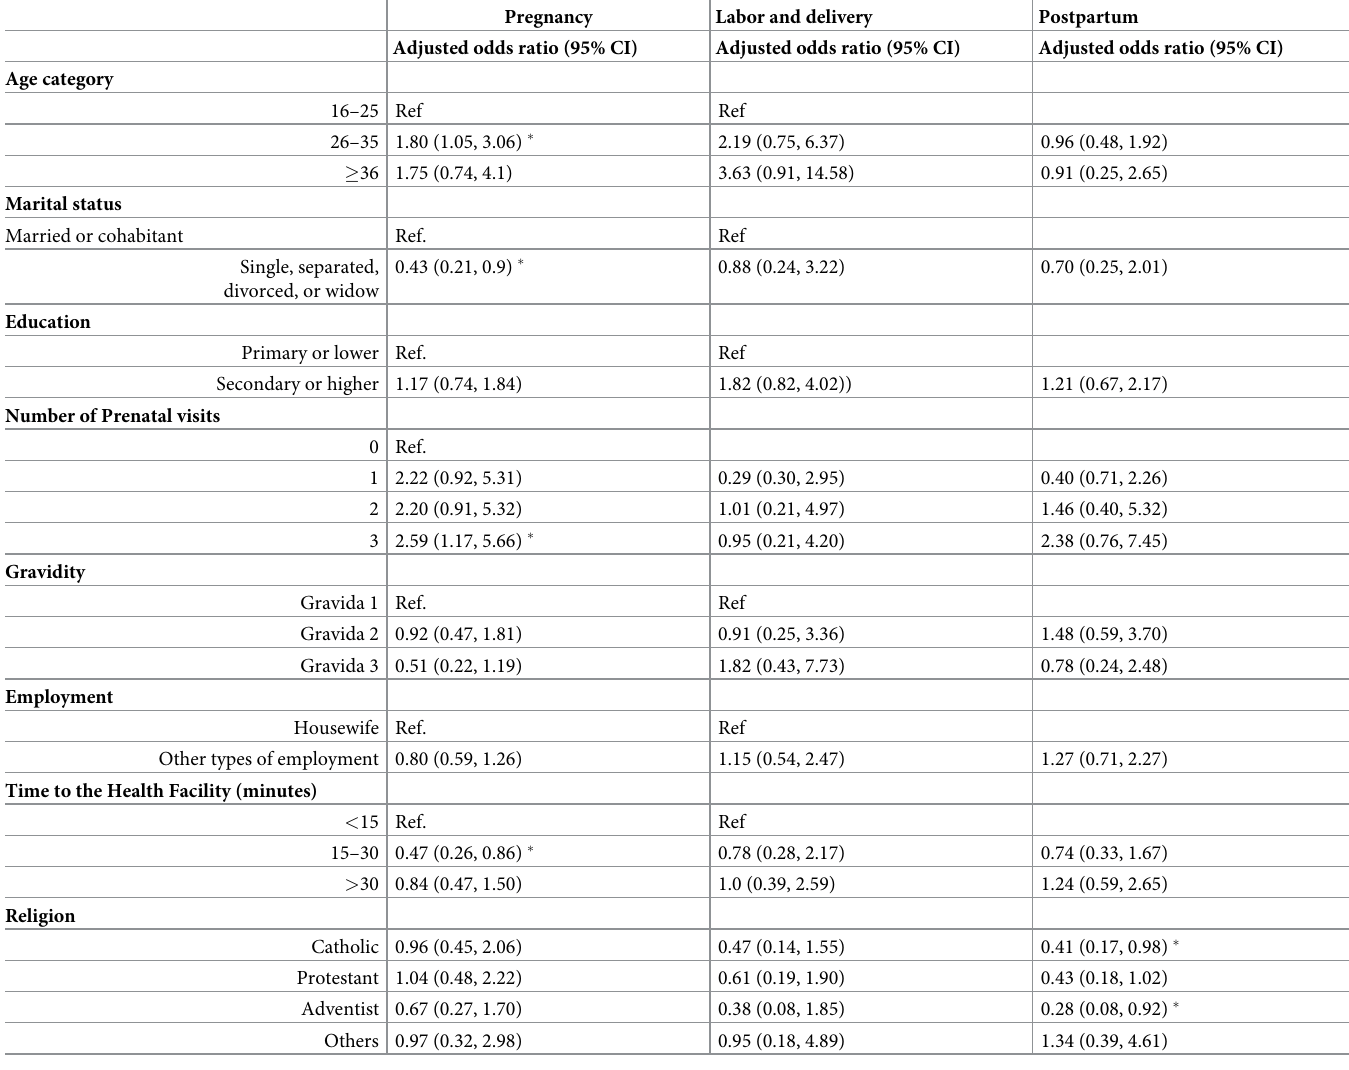
Table 3. Factors associated with the knowledge of at least three ODS during pregnancy, labor and delivery, and